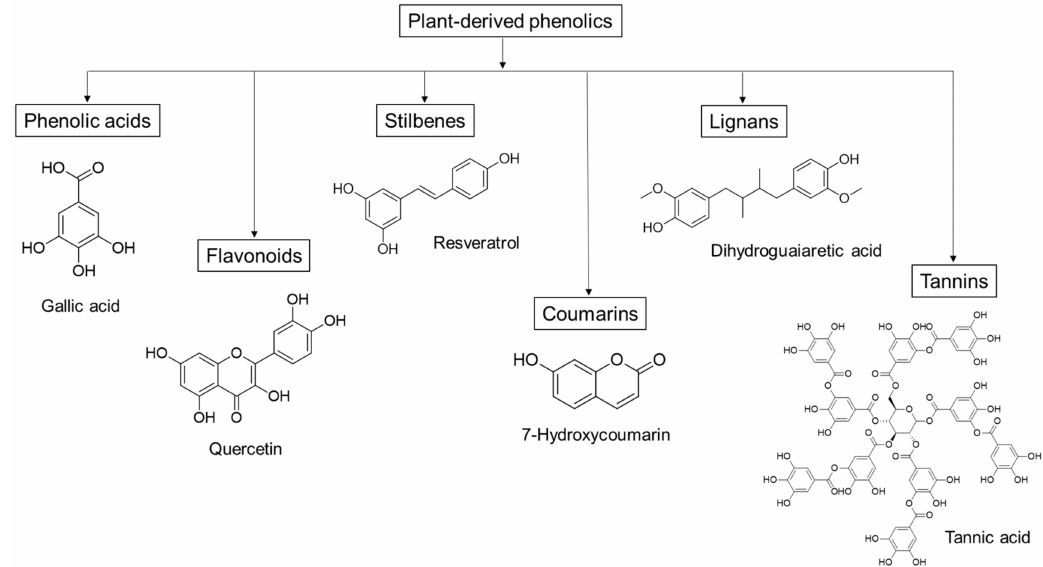
Figure 1. Groups of plant-derived phenolics, and some representative antimicrobial compounds with their chemical